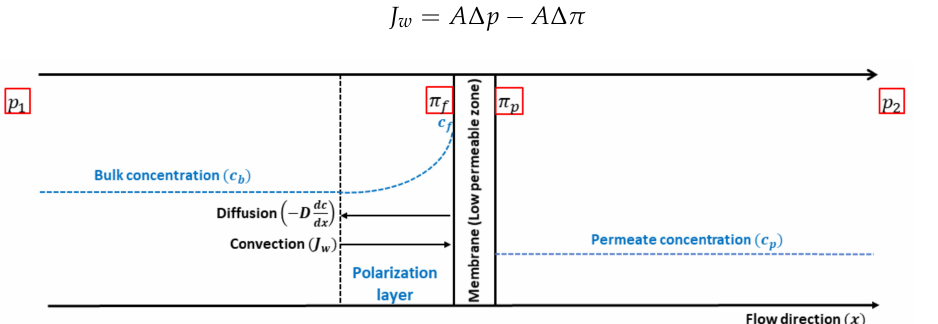
Figure 2. Graphical representation of concentration polarization due to reverse osmosis. J w represents the resultant solvent flux, c represents the concentration, π represents the osmotic pressure, and p represents the applied hydraulic pressure. The subscript b , f , p represent the bulk concentration, the solute concentration on the wall of the membrane at the feed-side and the permeate solution, respectively. Subscripts 1 and 2 represent the inlet and outlet of the channel,